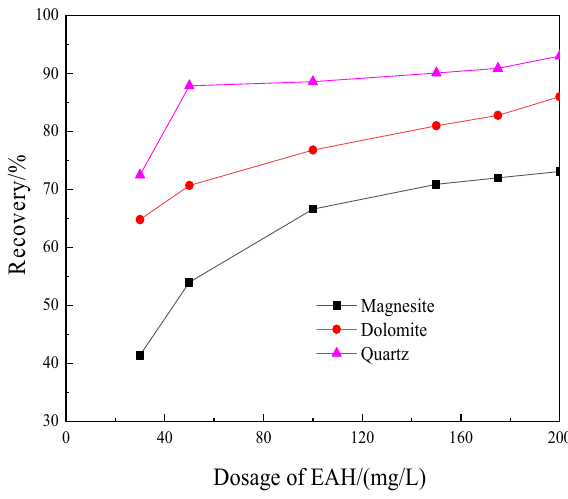
Figure 2. Experimental results of the dosage of the collector.